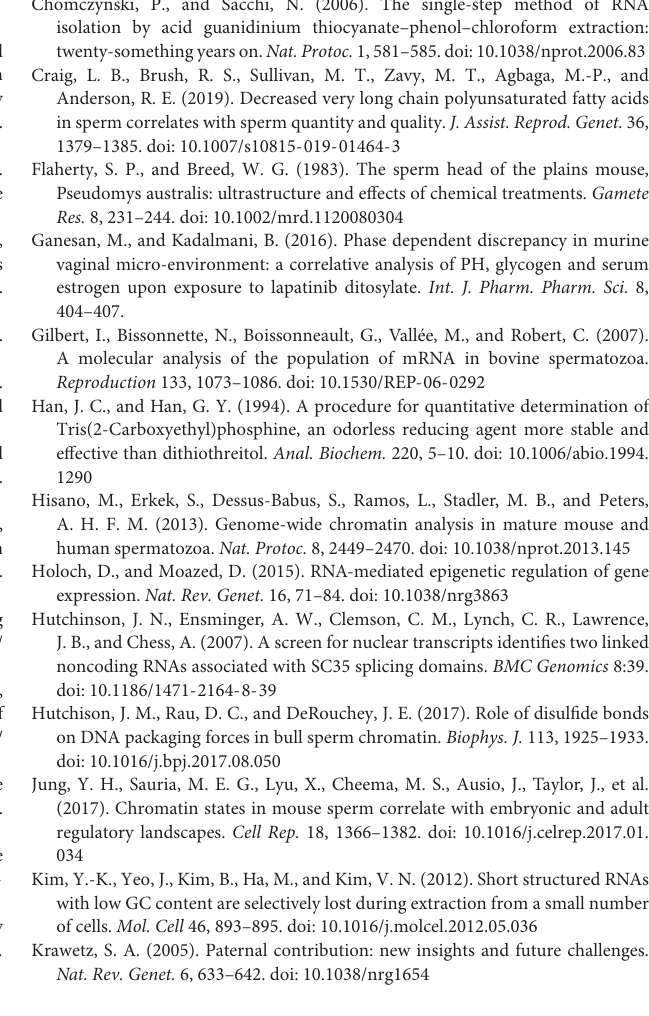
Supplementary Figure 1 | Quantification of residual genomic DNA in sperm RNA samples. (A,C) Bioanalyzer electropherograms of RNA concentration in fluorescence units (FU) for a given nucleotide length (nt). (A) Unusual peak at 2,000 nt is residual genomic DNA. Subsequent treatment with DNAse removes the peak. (B) Quantification of residual genomic DNA by fluorometry and plotted as a ratio against RNA amount per sample. (n = 4 per group). (C) Quantification of RNA integrity in somatic RNA shows no decrease of RNA integrity after DNAse treatment. Significant ANOVAs were followed by Tukey’s post hoc test, ∗ p < 0.05, ∗∗ p < 0.01, ∗∗∗ p <